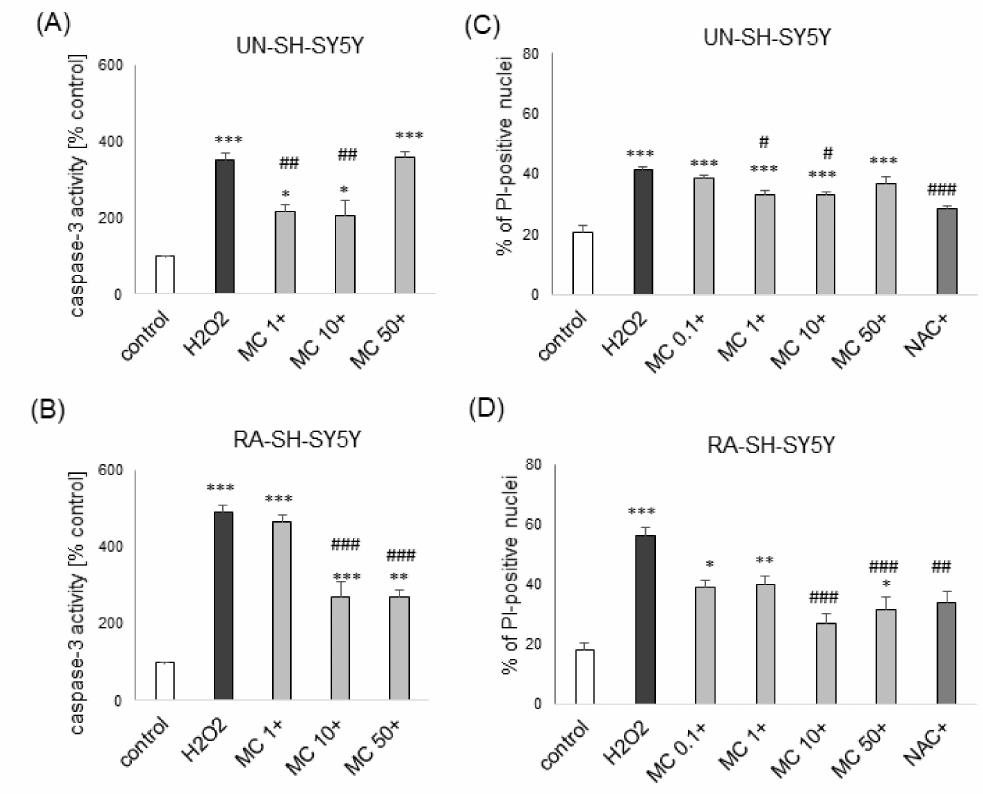
Figure 6. The protective e ff ects of MC against hydrogen peroxide (H 2 O 2 )-evoked UN- or RA-SH-SY5Y cell damage are mediated by inhibition of apoptotic and necrotic processes. ( A , B ) The e ff ect of 30-min pre-treatment with MC (1–50 µ M) followed by 9 h of exposure to H 2 O 2 (0.25 and 0.75 mM for UN- and RA-SH-SY5Y cells, respectively) on caspase-3 activity in UN-(A) and RA-(B) SH-SY5Y cells. Data were normalized to vehicle-treated cells and are presented as the mean ± SEM. ( C , D ) The e ff ect of 30-min pre-treatment with MC (0.1–50 µ M) or co-treated with N-acetylcysteine (NAC, 1 mM) followed by 24 h of exposure to H 2 O 2 (0.25 and 0.75 mM for UN- and RA-SH-SY5Y cells, respectively) on the number of necrotic nuclei measured by propidium ioide (PI) staining and flow cytometry in UN-(C) and RA-(D) SH-SY5Y cells. Data are presented as the mean ± SEM percentage of necrotic nuclei. *** p < 0.001, ** p < 0.01 and * p < 0.05 vs. vehicle-treated cells; ### p < 0.001, ## p < 0.01 and # p < 0.05 vs. H 2 O 2 -treated